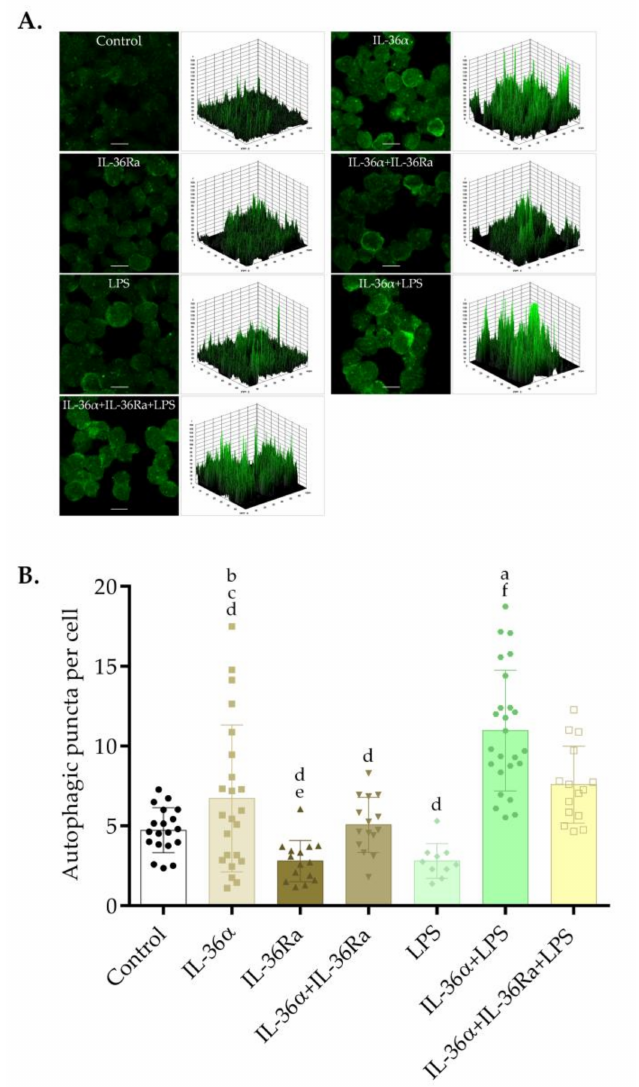
Figure 2. IL-36 α and LPS cooperatively increase the accumulation of LC3B-positive vacuoles. THP-1 cells were treated with 10 ng/mL IL-36 α , IL-36Ra, and LPS alone or in combination for 6 h, and the intracellular localization of LC3B was analyzed. Control cultures incubated in parallel were left untreated. ( A ) Immunofluorescence assays showing the fluorescence intensities of LC3B-positive vacuoles. The samples were stained for endogenous LC3B protein, and images were obtained by confocal microscopy. The images were subjected to fluorescence intensity analysis by using the Image J software. The 3D surface plots represent the intensity values of the whole image. The results are representative of two independent experiments. Scale bar, 10 µ m. ( B ) The average numbers of LC3B-positive autophagic vacuoles. The LC3B-positive autophagic vacuoles were automatically quantified with Image J software. The values on the bar graphs denote the means ± SD of the results of two independent experiments. p values were calculated by the ANOVA test with the Tukey post-test. a p < 0.0001 vs. Control; b p < 0.01 vs. IL-36Ra; c p < 0.05 vs. LPS; d p < 0.001 vs. IL-36 α -LPS combination; e p < 0.05 vs. IL-36 α -IL-36Ra-LPS combination; f p < 0.001 vs. IL-36 α -IL- 36Ra-LPS